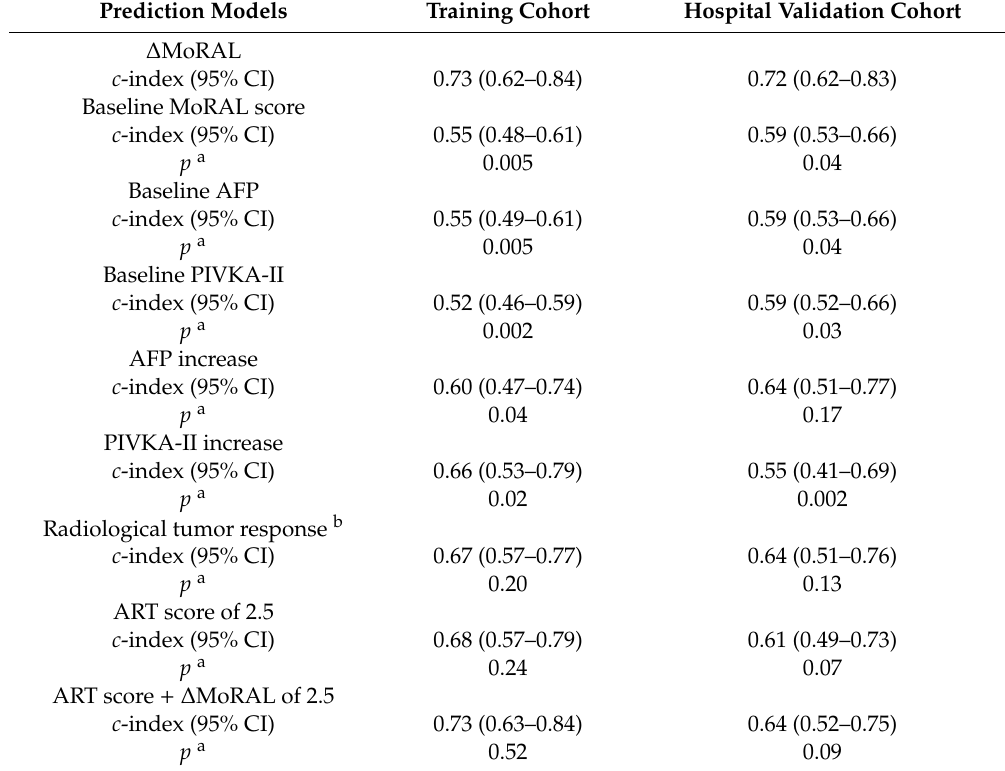
Table 4. Comparison between ∆ MoRAL and other models for predicting overall